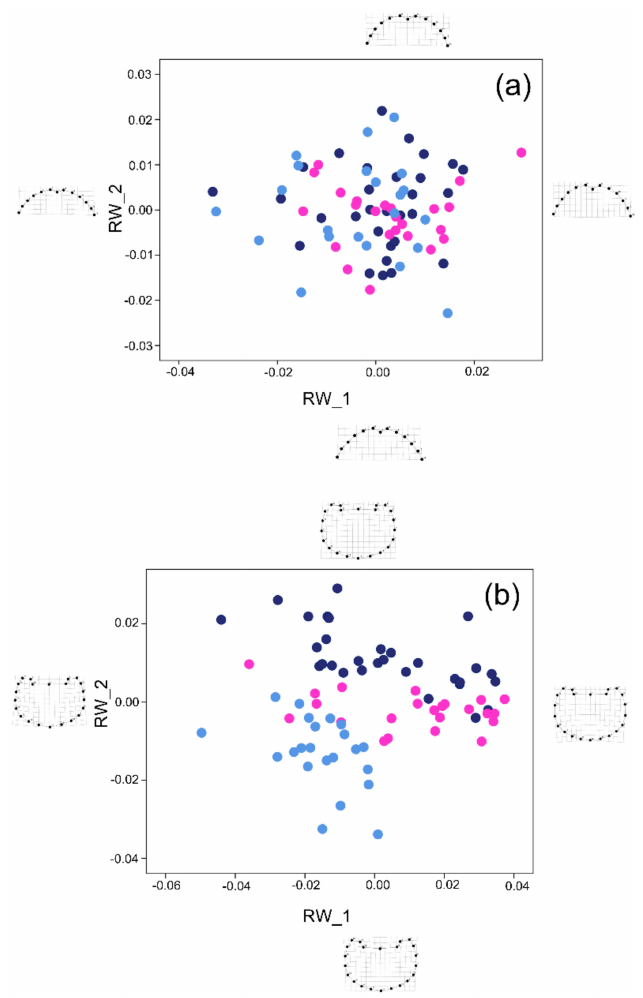
Figure 3. Shape analysis. Scatterplot of the RWs 1 and 2; morphs are distinguished by dark blue (major males), light blue (minor males), and fuchsia (females) dots. ( a ) Head, showing 59.58% of the overall shape variation; ( b ) pronotum, showing 66.54% of the overall shape variation. On both plots, the deformation grids of the two axes extremities are